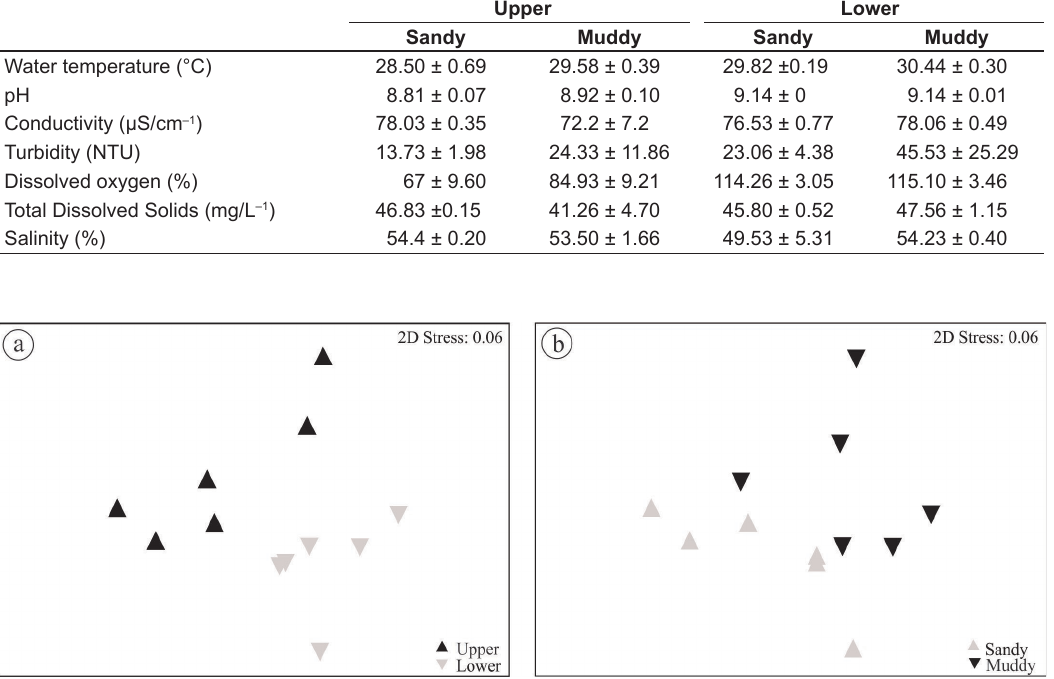
Figure 2. Multidimensional scaling ordination model of environmental parameters obtained from Tubarão river (Macau, Rio Grande do Norte). (a) Upper and lower areas of the estuary; (b) Sandy and muddy substrates.